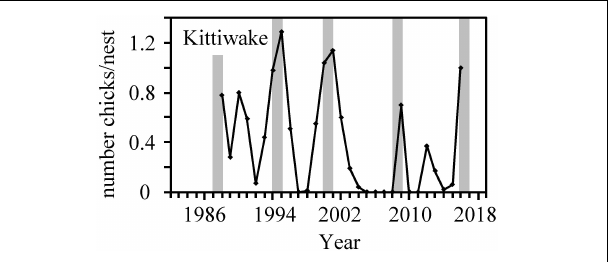
FIGURE 11 | The breeding success of the Faroe kittiwake from Hátún et al. (2017b). The gray bars are equivalent to the gray bars in Figure 4